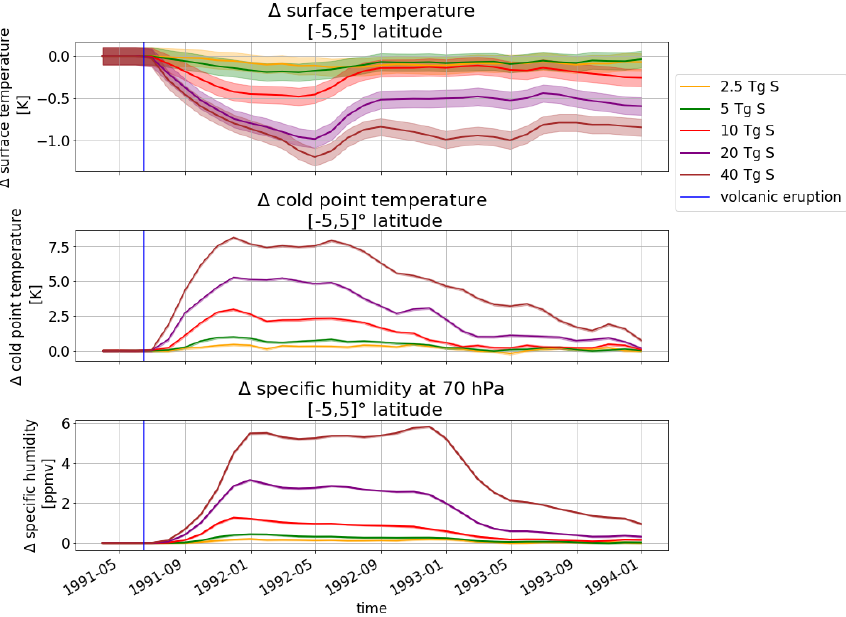
Figure 4. Temporal evolution of the inner tropical mean anomaly in surface temperature, cold-point temperature and stratospheric water vapor between volcanically perturbed and unperturbed ensemble runs. The ensemble means are shown with their standard errors. The time of the volcanic eruption is indicated by a vertical blue line.